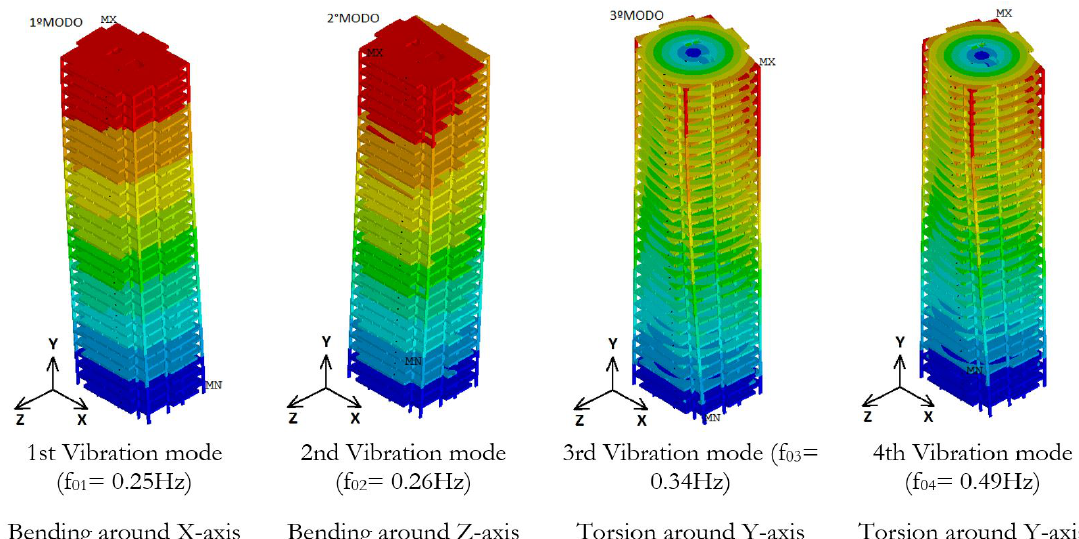
Figure 8. Vibration modes of the investigated